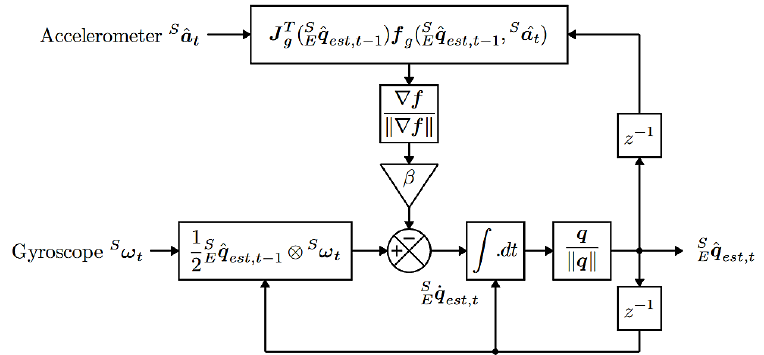
Figure 11. Block diagram of Madgwick’s filter in basic IMU (inertial measurement unit) application [35].